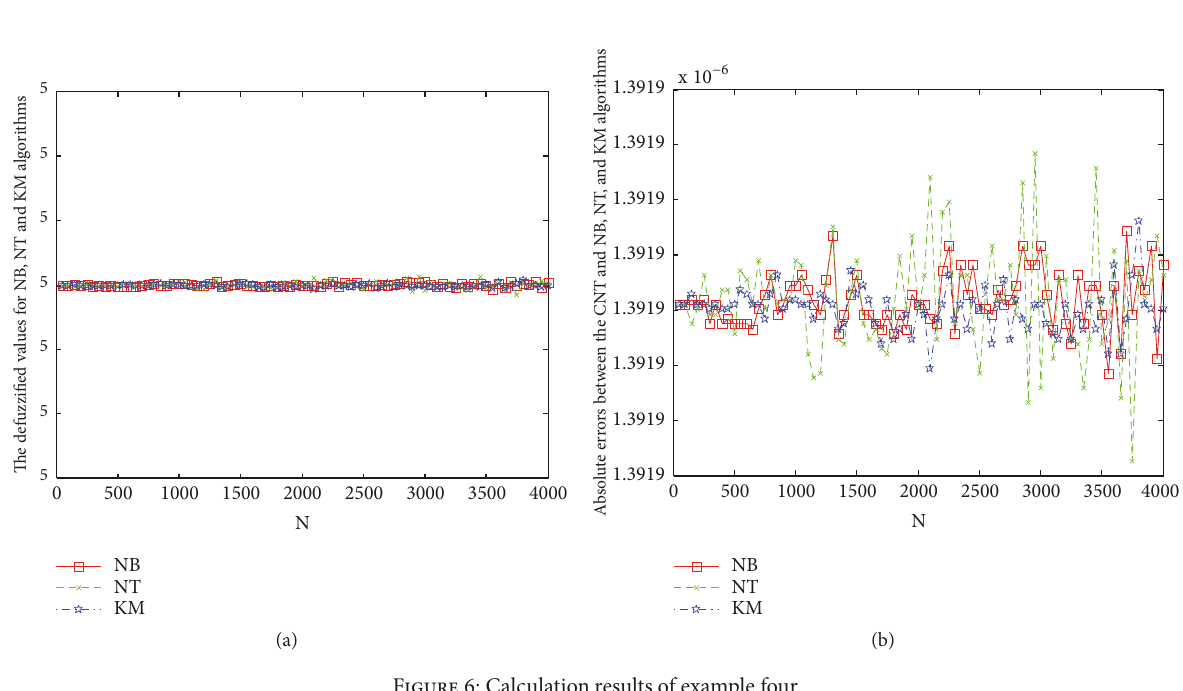
Figure 5: Calculation results of example three.